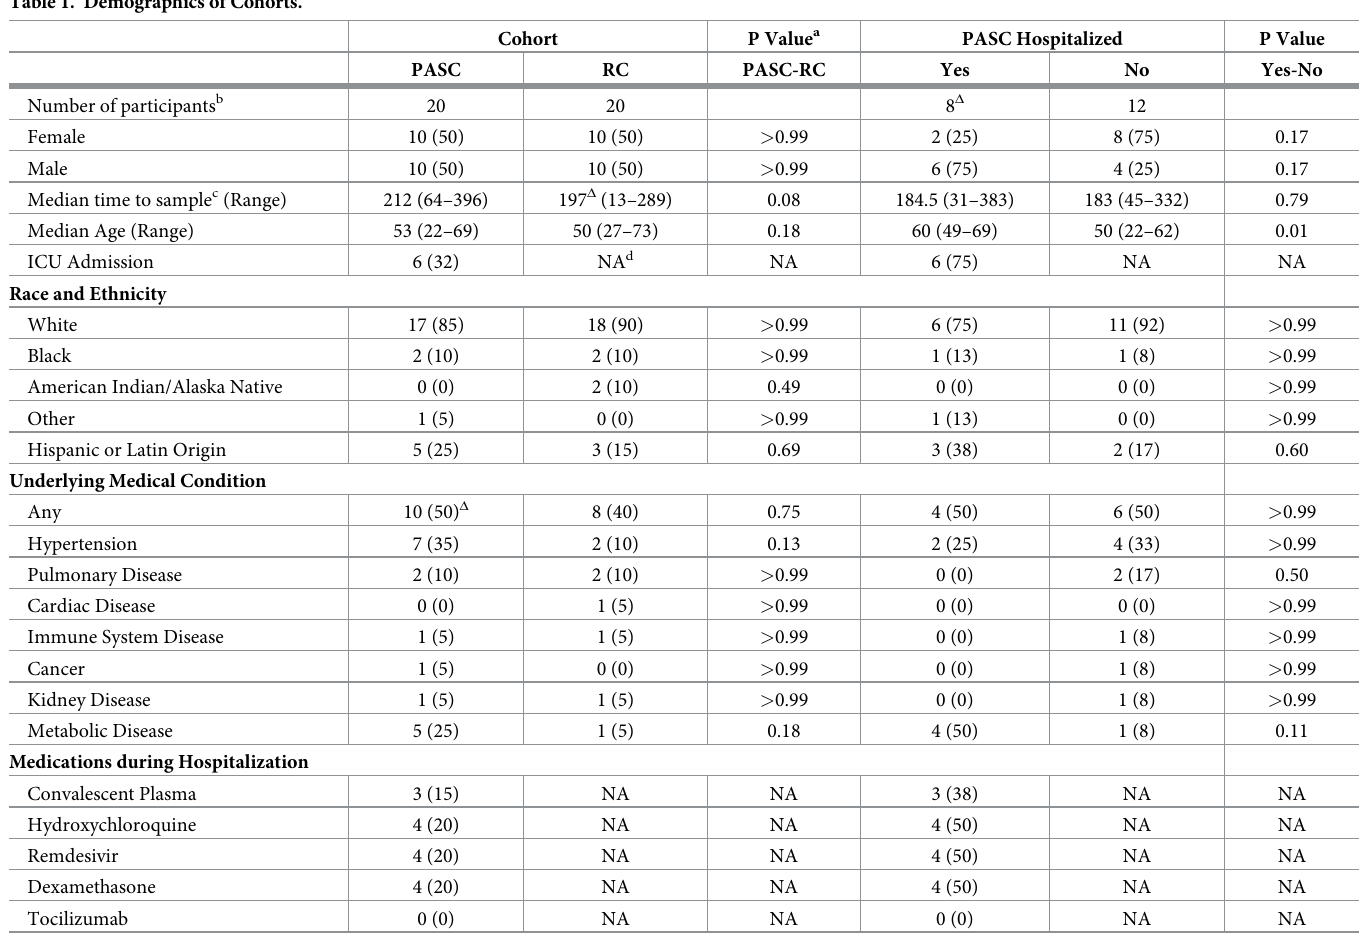
Table 1. Demographics of